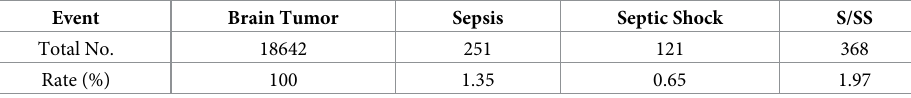
Table 1. Sepsis and septic shock